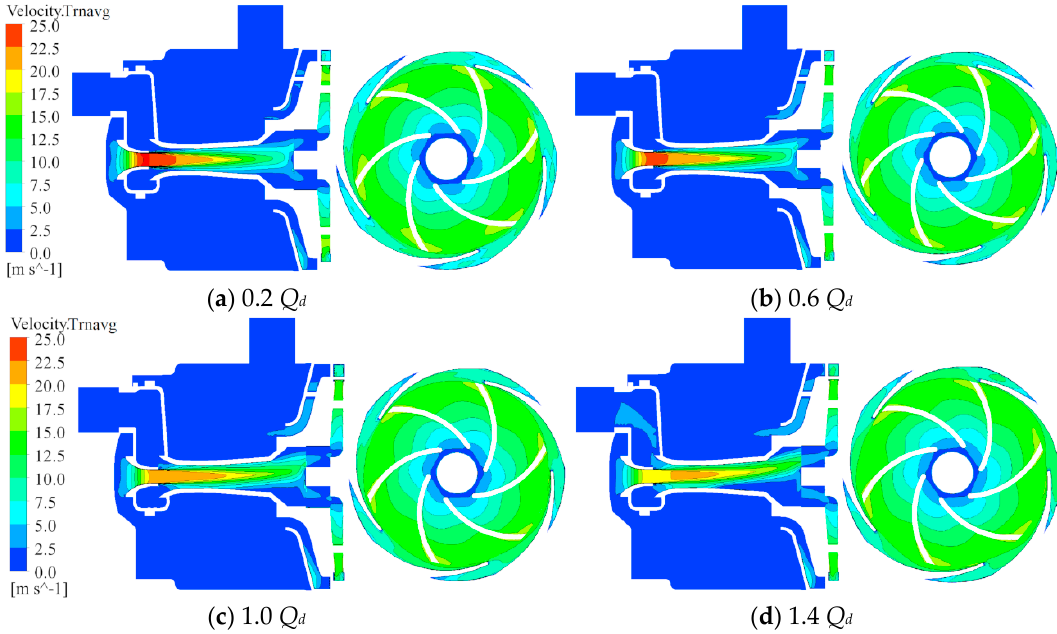
Figure 6. Time-averaged distribution contours of absolute velocity on two planes under four conditions.